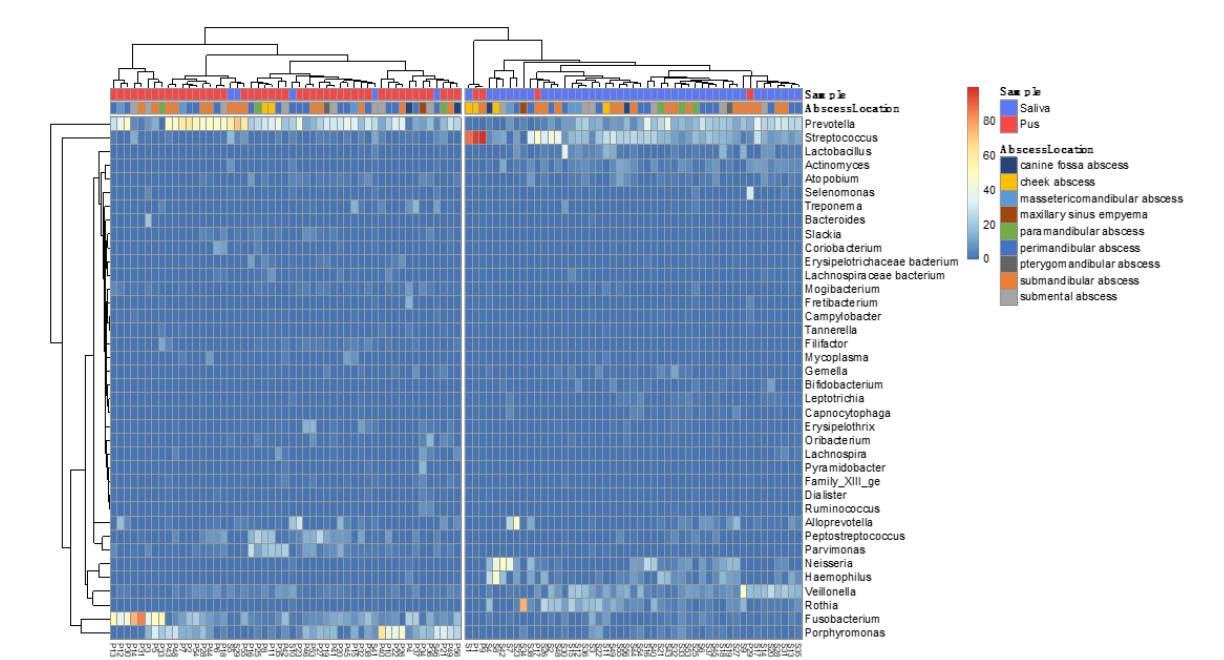
Figure 8. Heatmap of all saliva and pus samples ( n = 100). Colors show the relative frequency of the reads of the most frequent bacterial genera (sum of rows > 20%). Hierarchical clustering with dendrogram (method: ward with Euclidean distance). It is demonstrated that the samples are almost completely separated by clustering, indicating the different compositions of the samples. The heatmap also shows that abscess location has no significant influence on the composition of the microbiome.